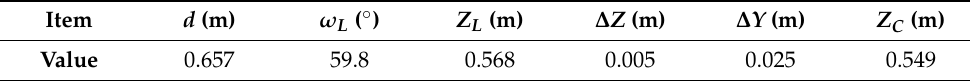
Table 4. Calibration results of eccentric distances and camera elevation to the calibration board.